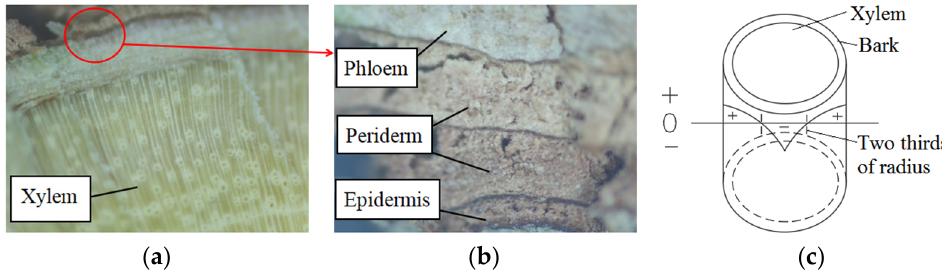
Figure 1. Structure of jujube bark under microscope and distribution law of tree growth stress: ( a ) microstructure of jujube trunk in cross-section under microscope; ( b ) microstructure of jujube bark in cross-section; ( c ) distribution law of tree growth stress, “+” represents the tensile stress area and “ − ” represents the compressive stress area.